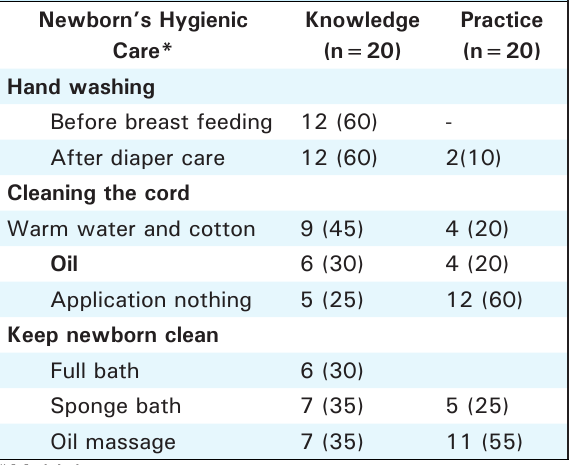
Table 9. Knowledge and Practice on Newborn’s Hygienic Care.